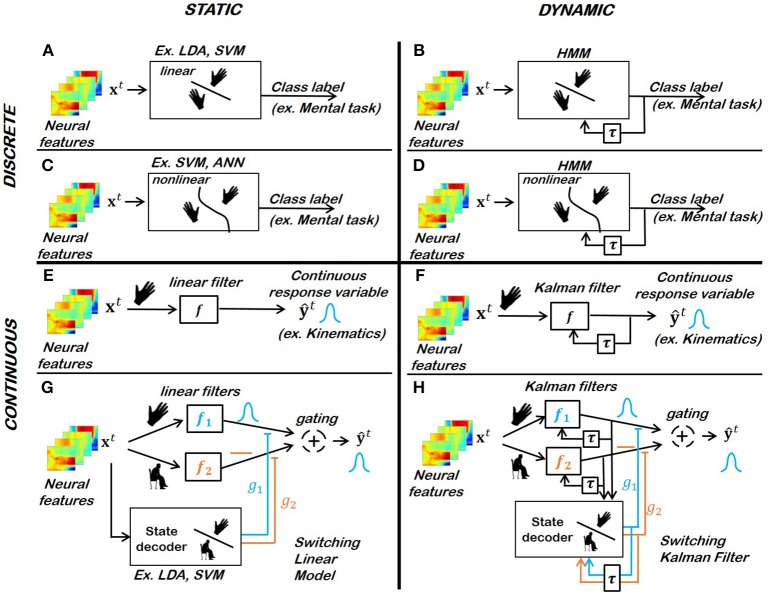
Popular motor BCI decoders for biomimetic kinematic and mental-task decoding strategies. (A) Linear static classifier for discrete response variables (Yanagisawa et al., 2012; Hotson et al., 2016). (B) Linear dynamic classifier for discrete response variables (Fifer et al., 2014). (C) Non-linear static classifier for discrete response variables (Kayikcioglu and Aydemir, 2010; Bhattacharyya et al., 2011). (D) Non-linear dynamic classifier for discrete response variables. (E) Linear static filter for continuous response variables (Collinger et al., 2013; Wodlinger et al., 2015). (F) Linear dynamic filter for continuous response variable (Wu et al., 2002; Hochberg et al., 2012). (G,H) Switching static or dynamic decoders (Wu et al., 2003b; Bundy et al., 2016).